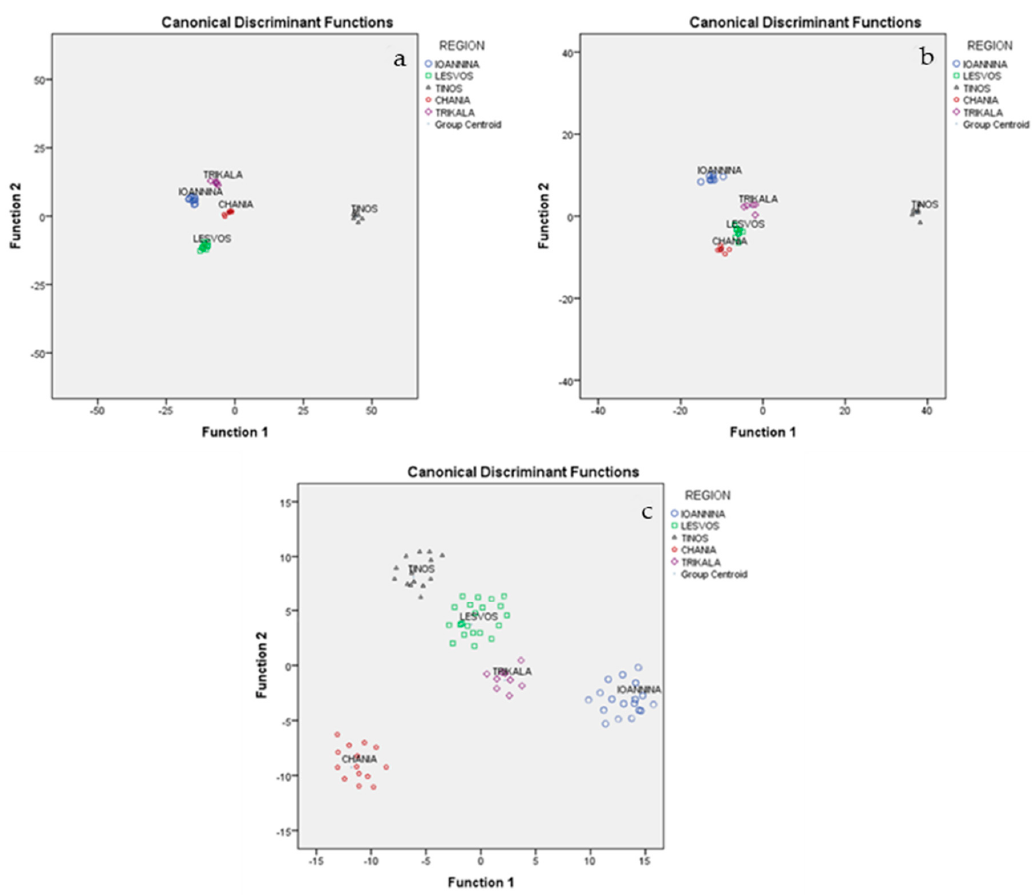
Figure 2. Geographical differentiation of graviera cheese based on the combinations of ( a ) FA composition and minerals, ( b ) CQP and FA composition and ( c ) CQP and